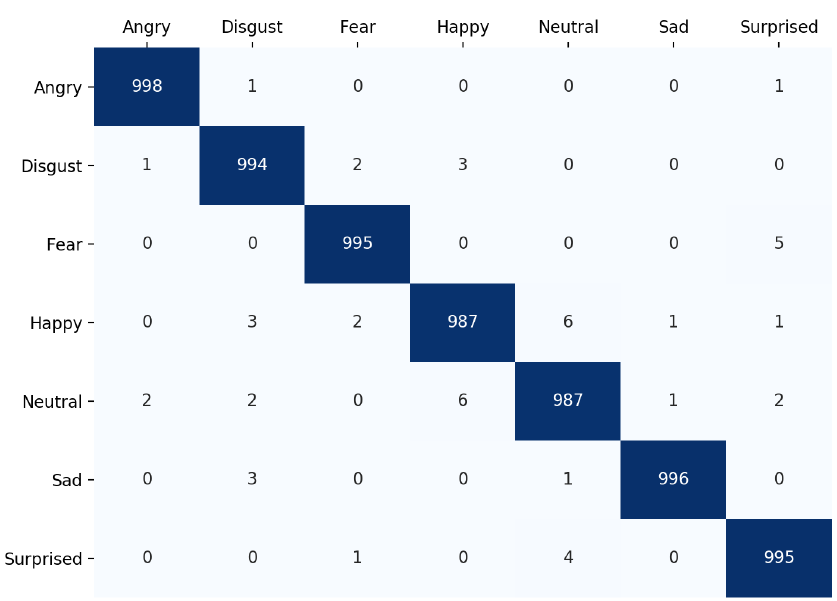
Figure 9. The confusion matrix on the FERG dataset. Each emotion class has 1000 images in the test set. The confusion matrix of the proposed model on the JAFFE dataset is shown in Figure